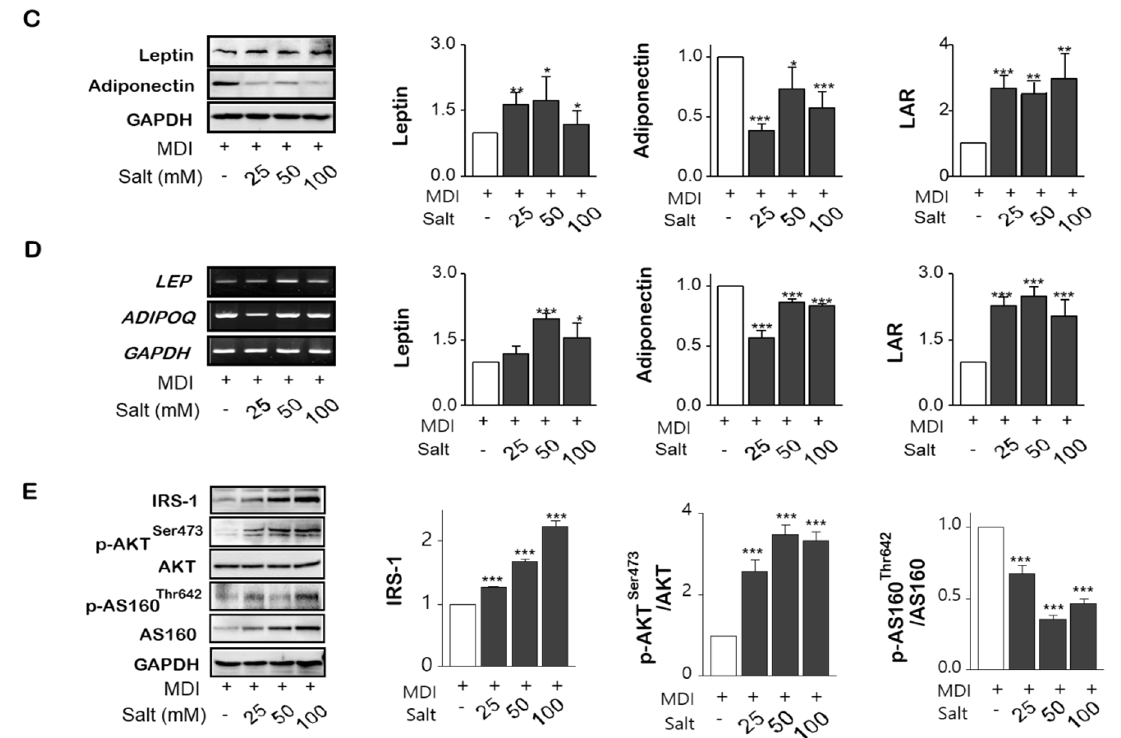
Figure 3. Salt modulates the production of pro-inflammatory cytokines and insulin resistance in adipocytes. Adipocytes were pretreated with concentrations of salt (0 to 100 mM) during differentiation of adipocytes. Pro-inflammatory cytokines were detected by western blotting ( A-a ), ELISA ( A-b ), and flow cytometry ( B-a , -b ). The leptin and adiponectin, and leptin/adiponectin ratio (LAR) were analyzed by western blotting ( C ) and semi-quantitative rt-PCR ( D ). Cell lysates were immunoblotted with antibodies against the insulin signaling such as IRS-1, phospho-IRS-1 (Ser 636/639 ), AS160, and phospho-AS160 (Thr 642 ). ( E ) Data are expressed as mean ± SE of three independent experiments or more. * p < 0.05, ** p < 0.01, *** p < 0.001, significant difference vs control.